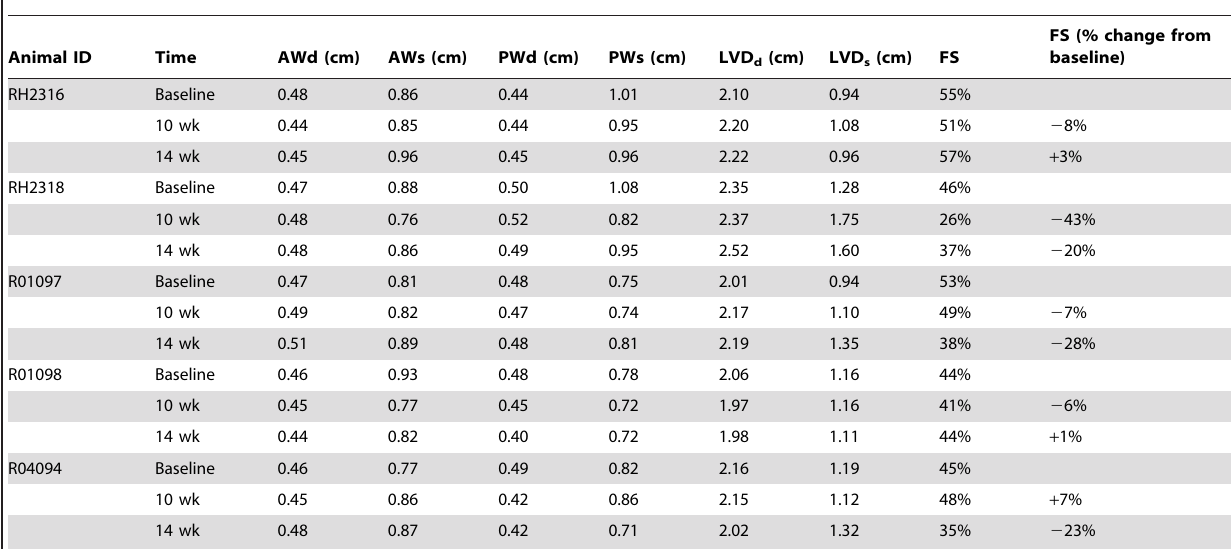
Table 4. Echocardiogram measurements at baseline, 10 and 14 weeks after 6-OHDA for each animal.